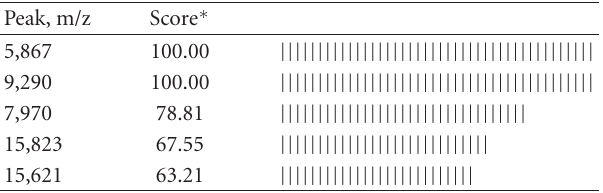
Table 2: Important peaks selected by the biomarker pattern soft- ware.